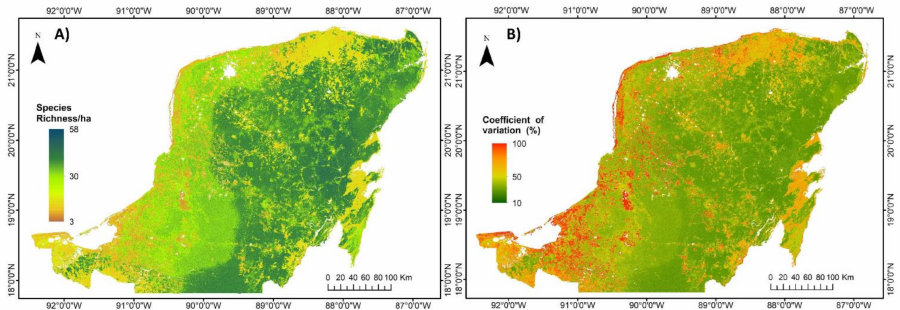
Figure 4. Estimated map of the species richness for the entire Yucatan Peninsula ( A ) and the uncertainty map measured with coefficient of variation ( B